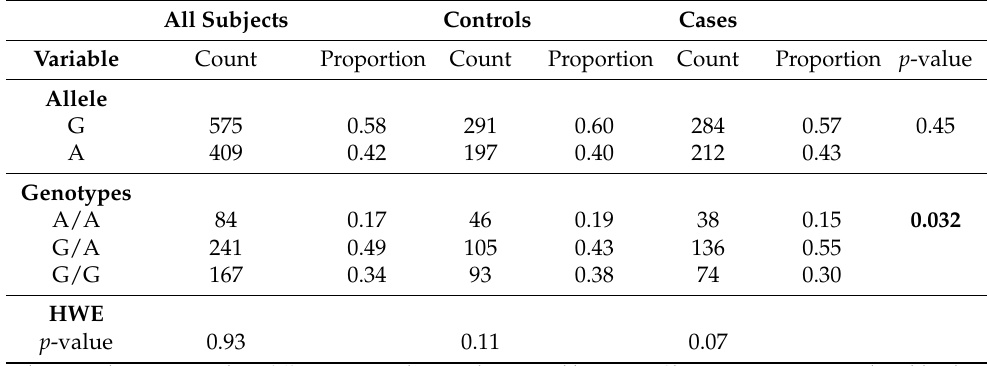
Table 3. Genotype and allele frequencies of MIR17 rs4284505 polymorphism.